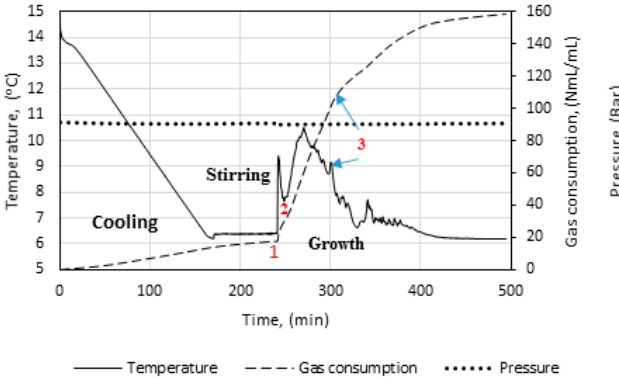
Figure 3. Pressure, temperature, and gas consumption data from a typical experimental run (141.4 mL cell, 50 mL water).